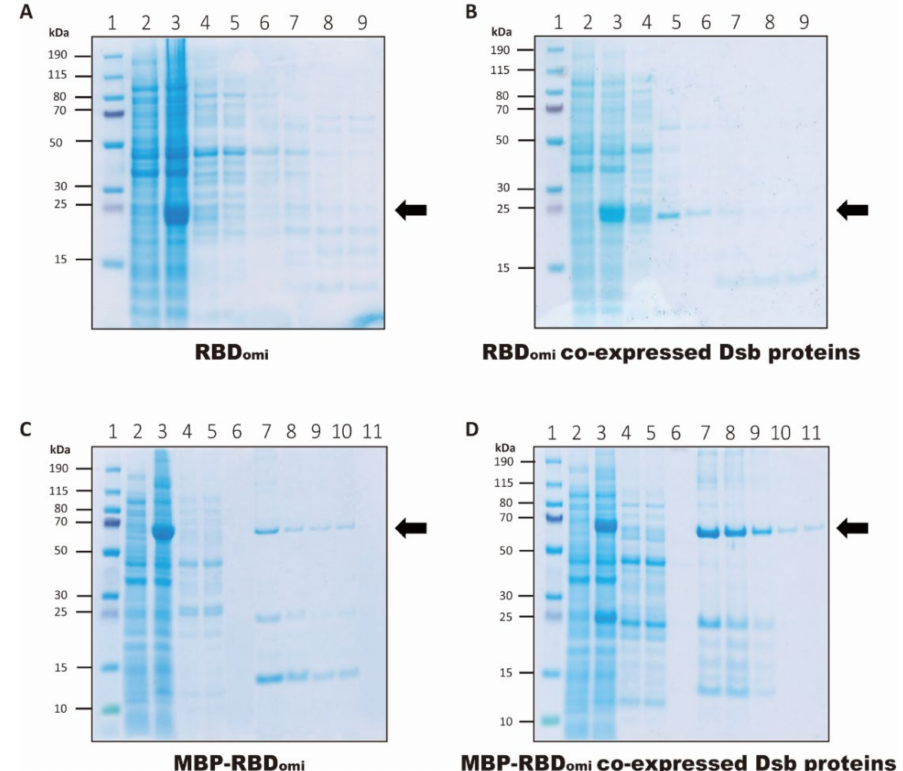
Figure 2. Expression and Ni-NTA purification of RBD omi and MBP-RBD omi . Purification of ( A ) RBD omi , ( B ) RBD omi co-expressed Dsb proteins, ( C ) MBP-RBD omi , and ( D ) MBP-RBD omi co- expressed Dsb proteins was analyzed by bis-tris SDS-PAGE. Black arrows indicate the band positions of the recombinant proteins. The lanes of SDS-PAGE are as follows: lane 1, protein size marker (Thermo); lane 2, cell lysate before IPTG induction; lane 3, cell lysate after IPTG induction; lane 4, periplasmic fraction obtained by osmotic shock; lane 5, Ni-NTA flow through fraction; lane 6, Ni-NTA wash fraction; lane 7 to 11, Ni-NTA elution fractions.